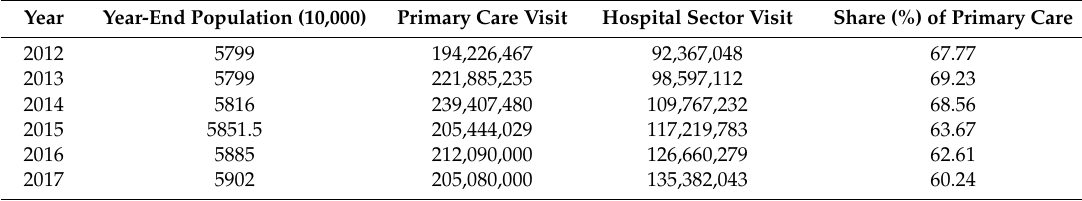
Table 1. Outpatient visit data for primary care and hospital sector in Hubei province,